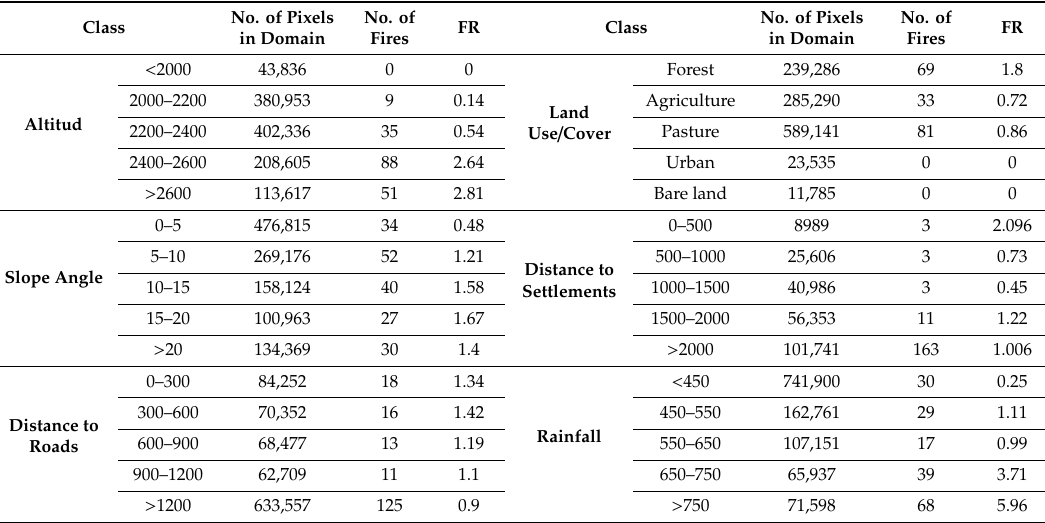
Table 4. Result of the FR model.